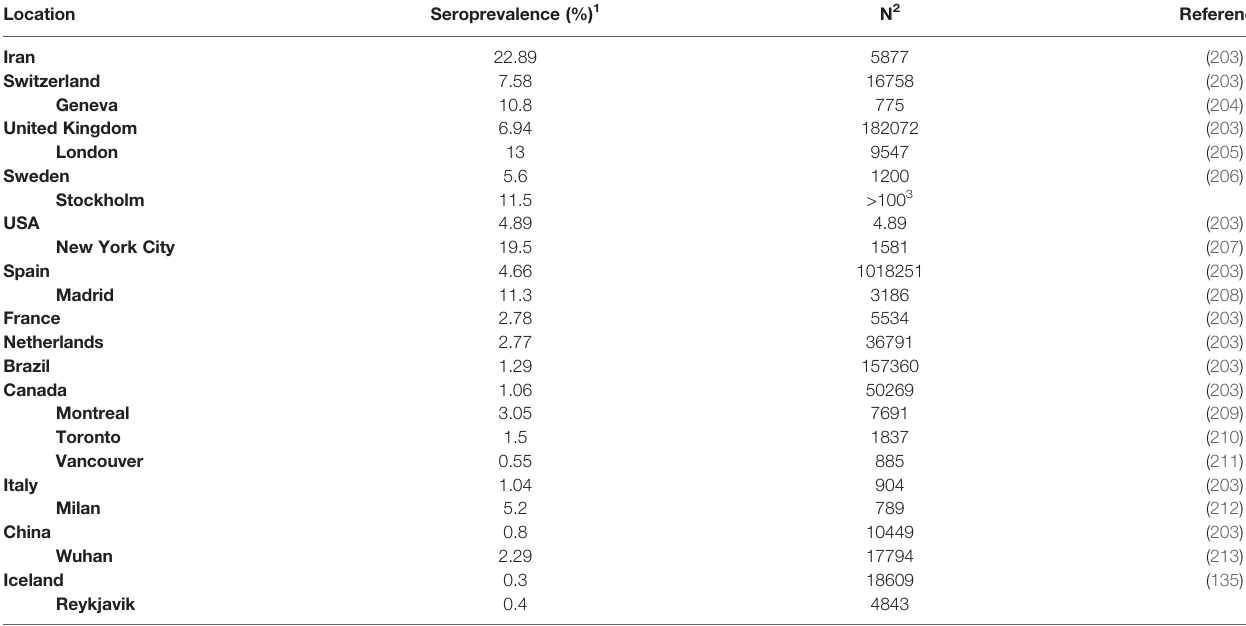
TABLE 3 | Seroprevalence of antibodies against SARS-CoV-2 in various countries and cities.